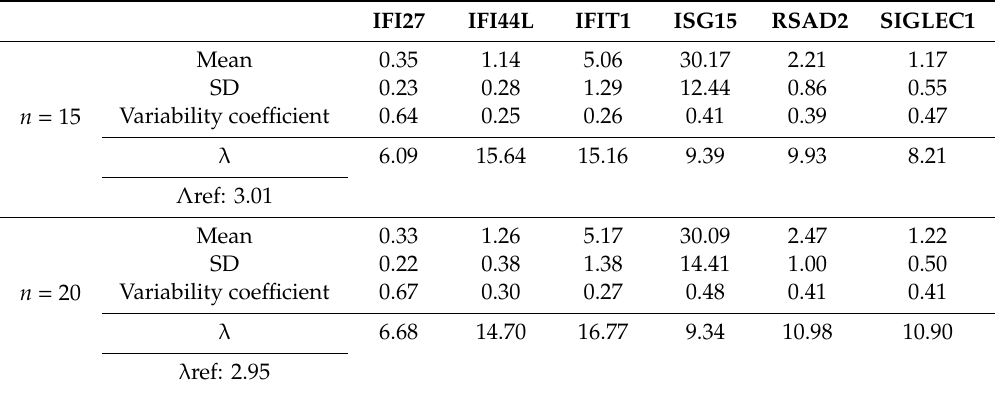
Table 5. Variability assessment for IFN-stimulated genes expression values evaluated in fifteen and twenty healthy subjects by in silico RNAseq analysis.